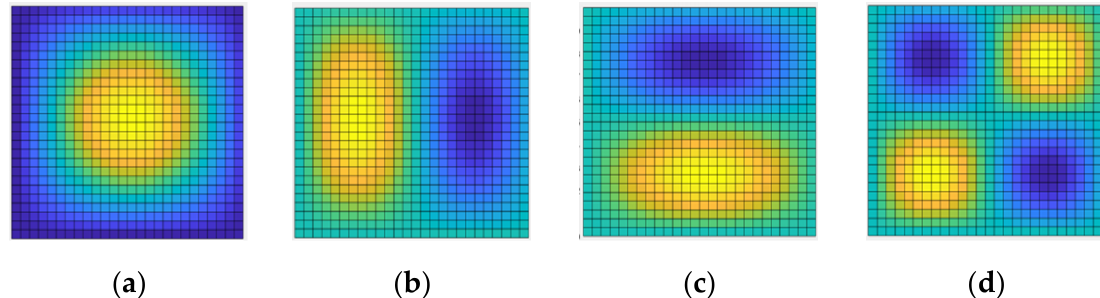
Figure 5. The first four-order vibration of MATLAB. ( a ) First order vibration mode, ( b ) second order vibration mode, ( c ) third order vibration mode, and ( d ) fourth order vibration mode.